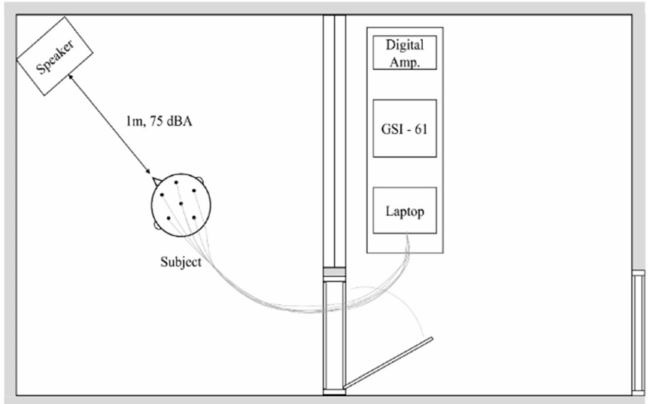
Figure 3. An image of testing conditions when recording